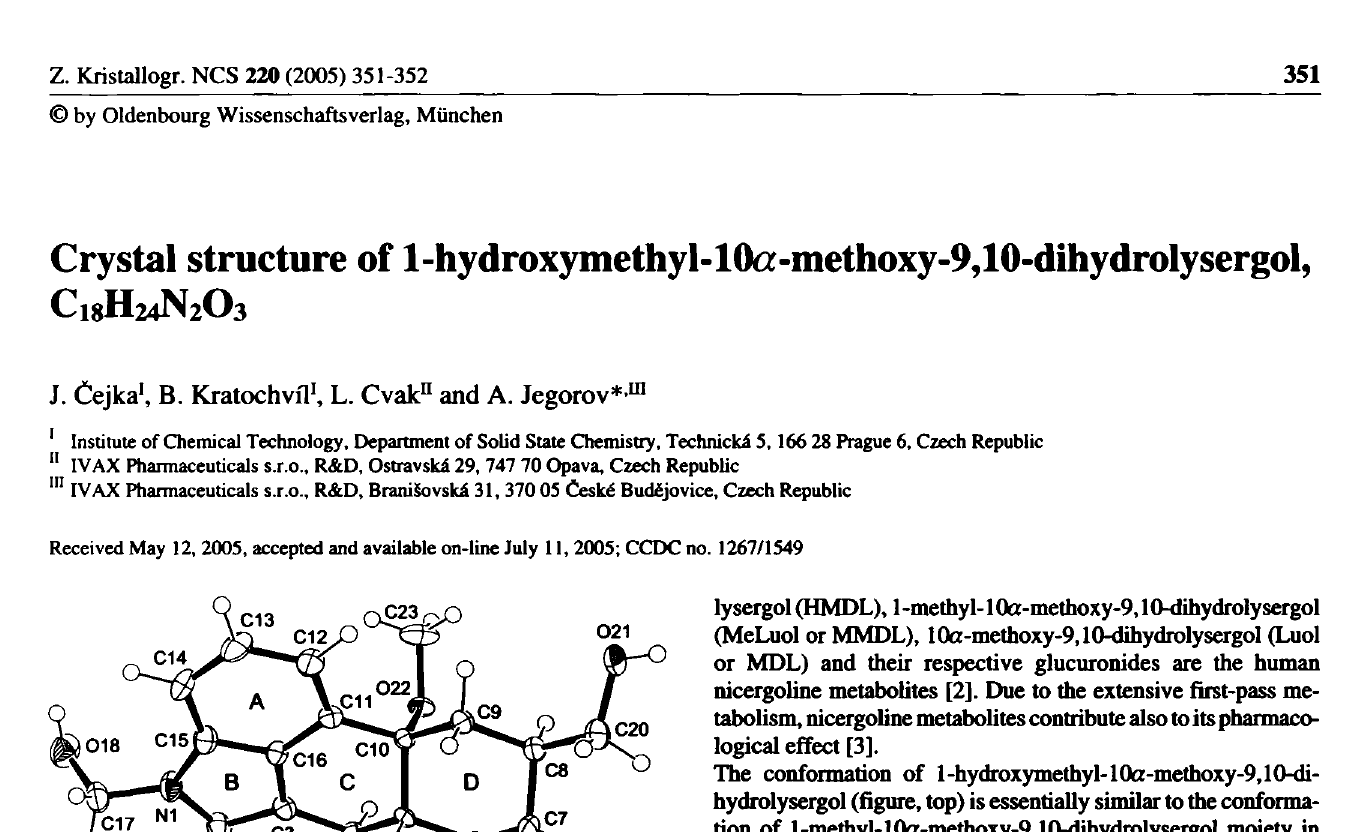
Table 1. Data collection and handling.